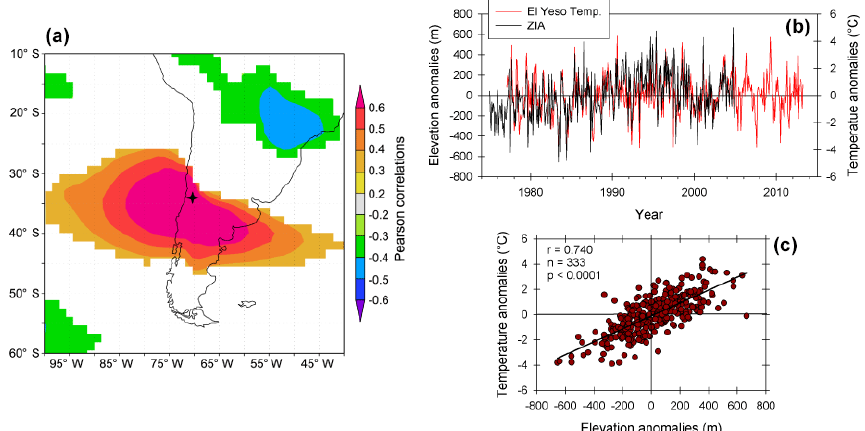
Figure 6. Panel (a) depicts a map showing the correlations ( p < 0.1) between mean warm season (October–March) temperatures at the El Yeso station and gridded warm season ERA-Interim mean temperatures for the 700mb geopotential height level over the 1979–2012 period. The black star marks the location of the El Yeso station. The diagram in (b) shows variations of mean monthly temperatures at El Yeso (1977–2013) and the mean monthly elevation of the 0 ◦ C isotherm (ZIA) derived from radiosonde data from the Quintero coastal station (1975–2004). To facilitate the comparison, both series are expressed as anomalies from their mean seasonal cycles. Panel (c) shows a scatterplot of the El Yeso temperature and ZIA anomalies depicted in (b) . Note the positive, highly significant correlation between these two variables. ZIA data were provided by J. Carrasco from Dirección Meteorológica de